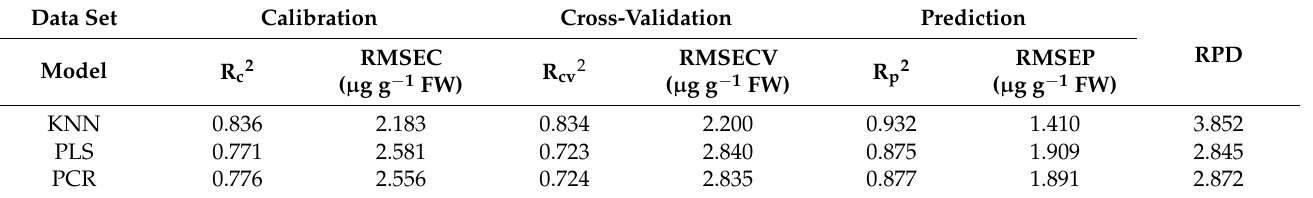
Table 4. Predicted results of ipomeamarone for C. fimbriata -infected sweetpotatoes by KNN, PLS, and